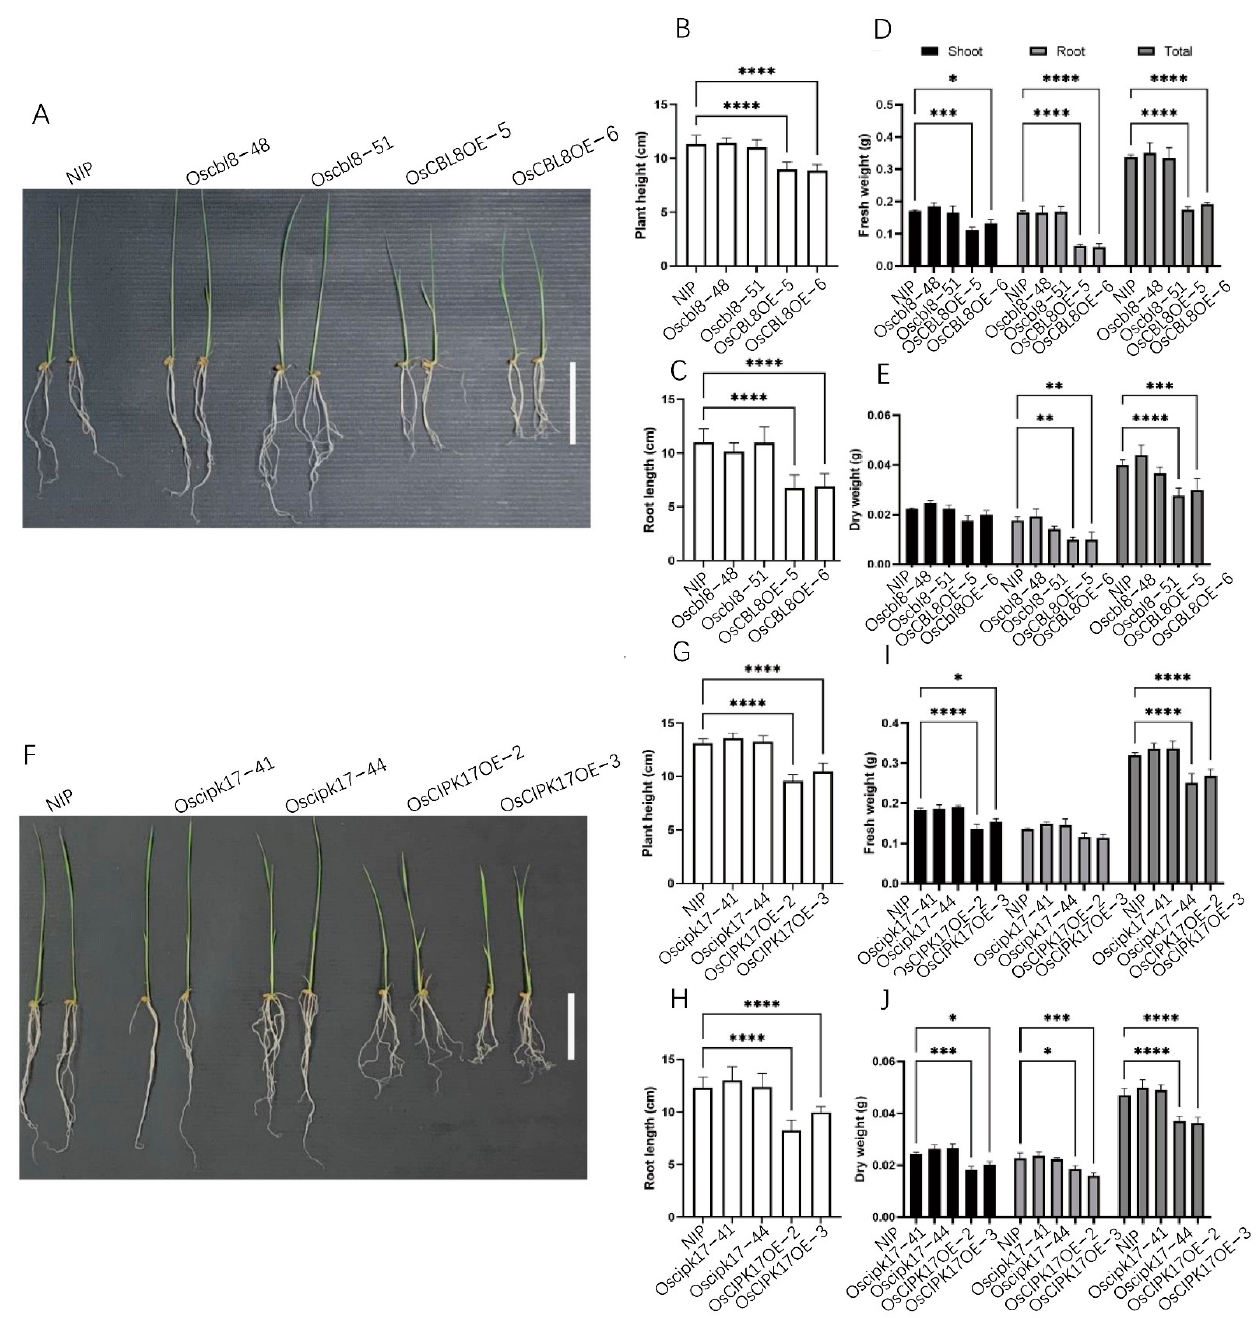
Figure 3. OsCBL8 and OsCIPK17 can regulate seedling growth. ( A , F ) Morphological phenotypes of OsCBL8 and OsCIPK17 knockout and overexpression lines on rice seedling growth. Photographs of 14-day-old plants are shown. Bar = 2 cm. ( B , C ) Plant height and root length of OsCBL8 knockout and overexpression lines. Data are mean ± SD from 20 biological replicates for OsCBL8. ( D , E ) Fresh and dry weight of knockout and overexpression lines of OsCBL8 were measured. ( G , H ) Plant height and root length of OsCIPK17 knockout and overexpression lines. Data are mean ± SD from 12 biological replicates for OsCIPK17 . Statistical analysis was performed using Šídák’s multiple comparisons test. ( I , J ) Fresh and dry weight of knockout and overexpression lines of OsCIPK17 were measured. Data are mean ± SD from three biological replicates. Statistical analysis was performed using Dunnett’s multiple comparisons test; * p < 0.05, ** p < 0.01, *** p < 0.001, **** p < 0.0001.